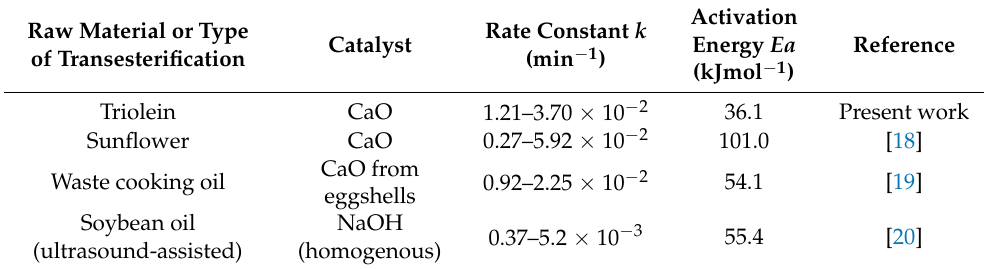
Figure 10. Arrhenius plots between ln k versus 1/T. Table 3. Rate constants and activation energies of the reaction for any catalyst and type of transesterification.